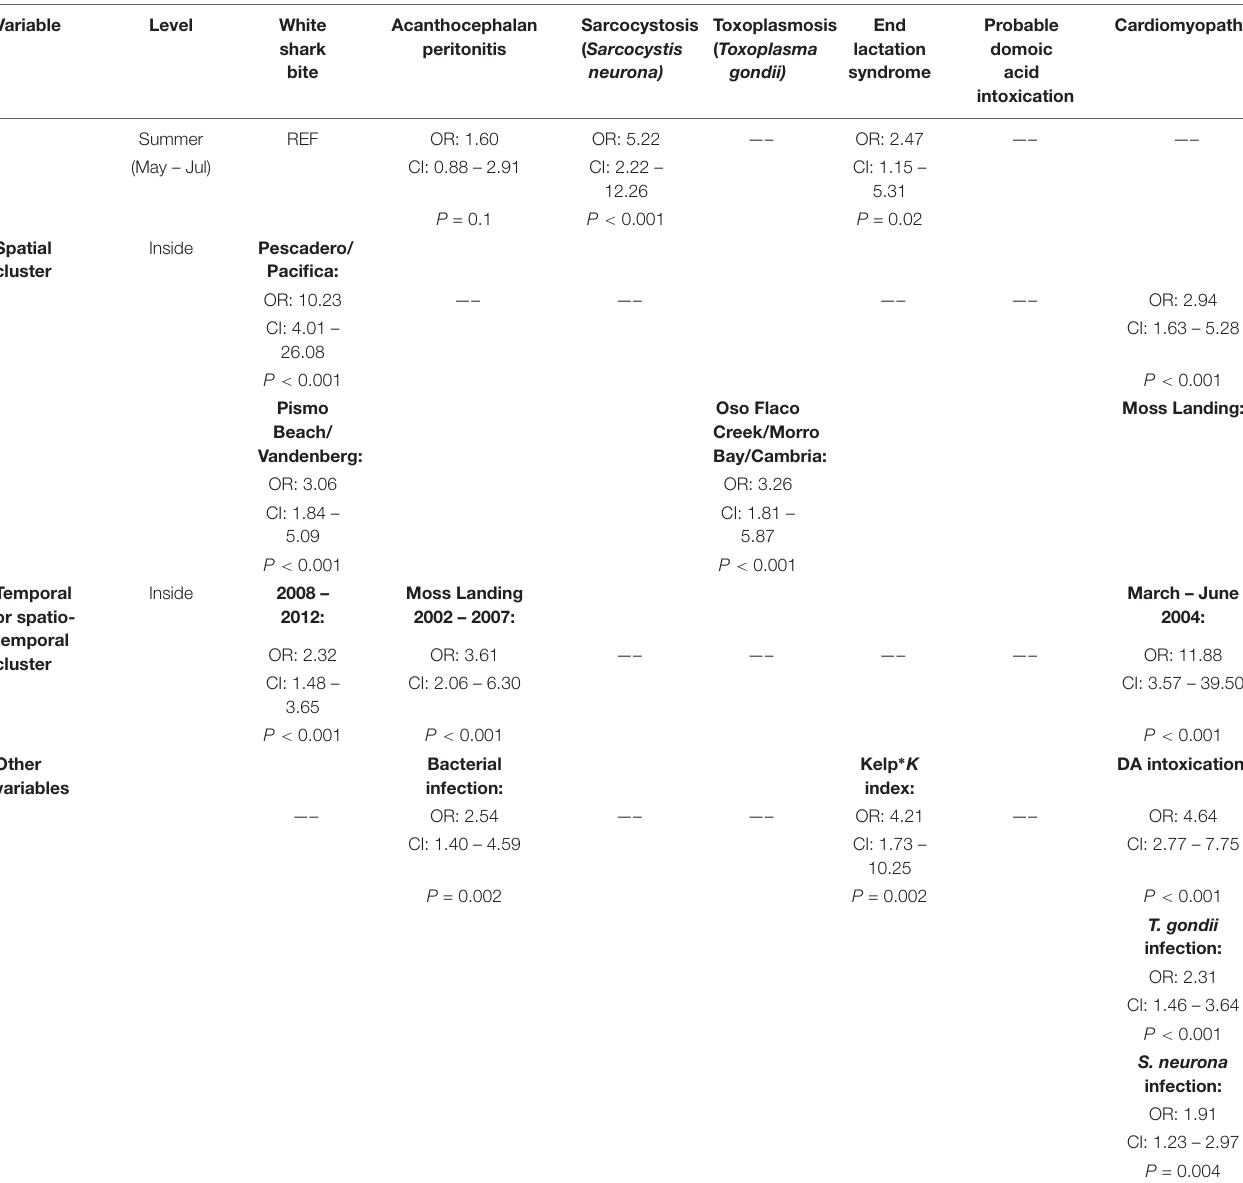
and Figure 4B ). Spatiotemporal SaTScan analysis of S. neurona mortality patterns revealed two overlapping high-risk clusters centered near Guadalupe and Cayucos in April 2004 ( Table 3 and Figure 3 ). Otters stranding within these clusters were approximately 10.5 times more likely to have fatal S. neurona infection ( P < 0.001), reflective of a previously described epizootic (Miller et al.,